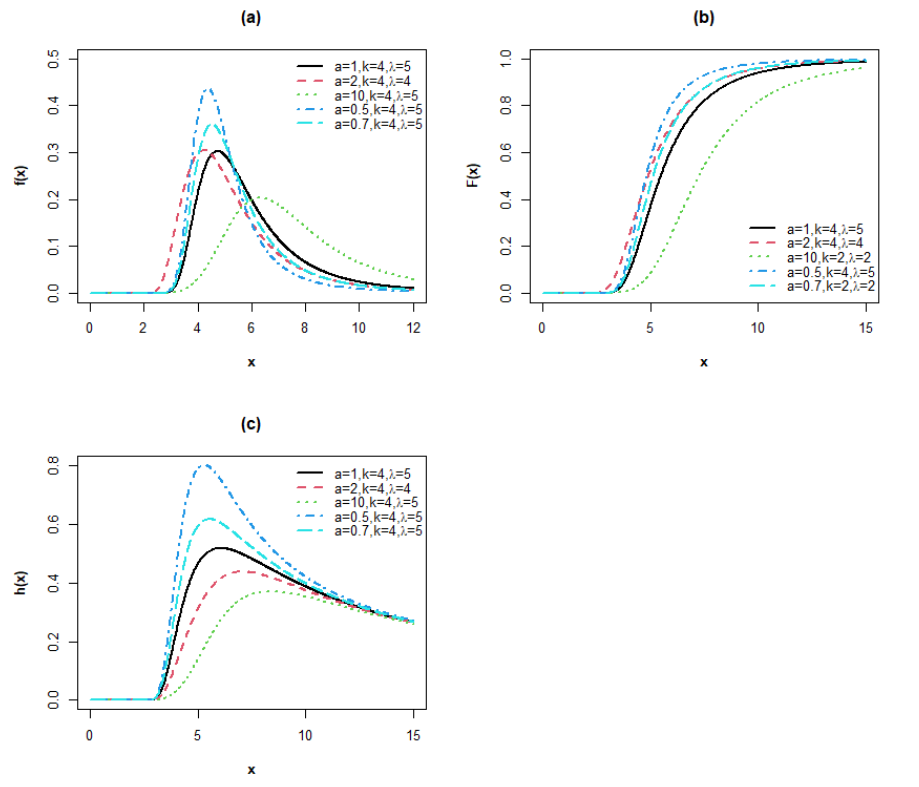
Figure 4. Plots of the ( a ) pdf, ( b ) cdf and ( c ) hrf for the MPoF